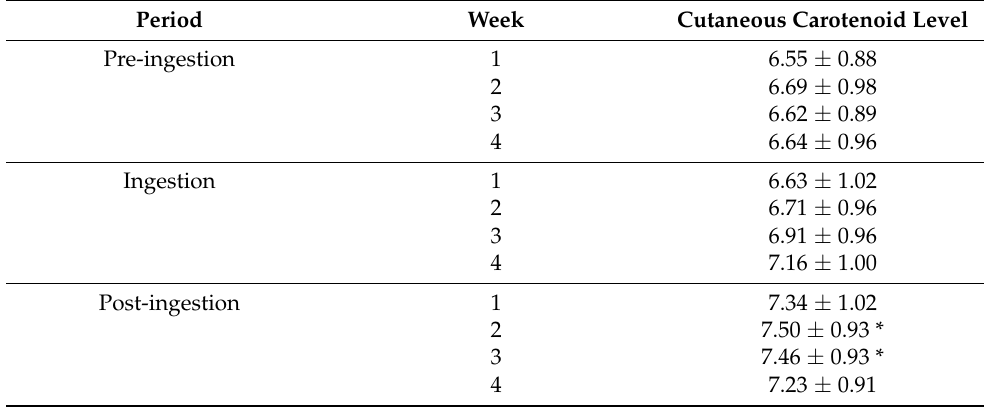
Table 2. Cutaneous carotenoid level.